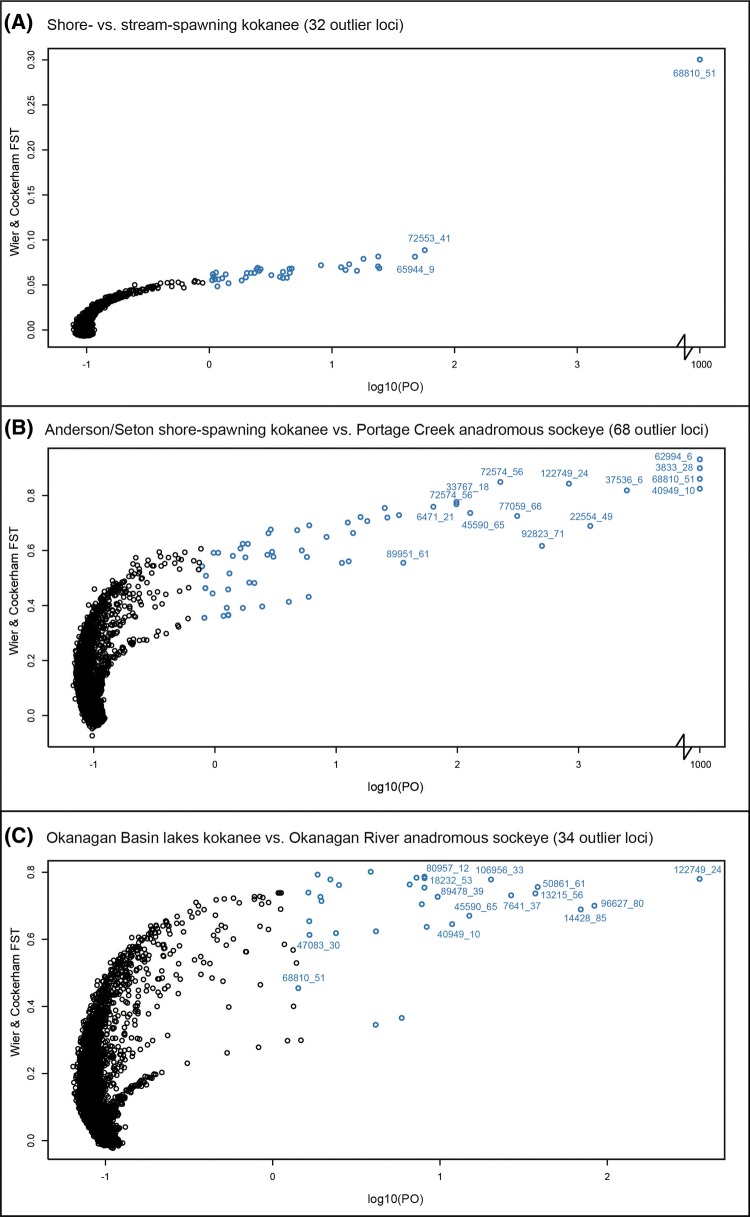
—FST outlier plots for the three primary combined ecotype comparisons performed in BAYESCAN (Foll and Gaggiotti 2008) including: (A) shore- versus stream-spawning kokanee; (B) Anderson/Seton Lake shore-spawning kokanee versus Portage Creek anadromous sockeye salmon; and (C) Okanagan Basin lakes kokanee versus Okanagan River anadromous sockeye salmon. Note the disjoint x-axis, with loci that had a q value of 0.0000, and a log10(PO) of 1,000 brought in to aid visibility.